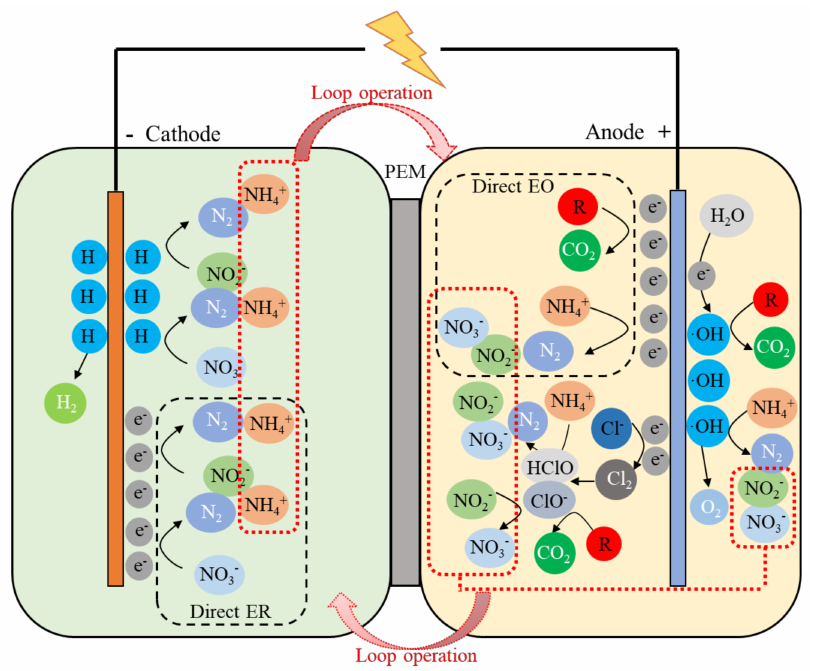
Figure 6. Schematic diagram of the electrolysis system. ER, electrochemical reduction; EO, electro- chemical oxidation; R, organic compounds; PEM, proton − exchange membrane.